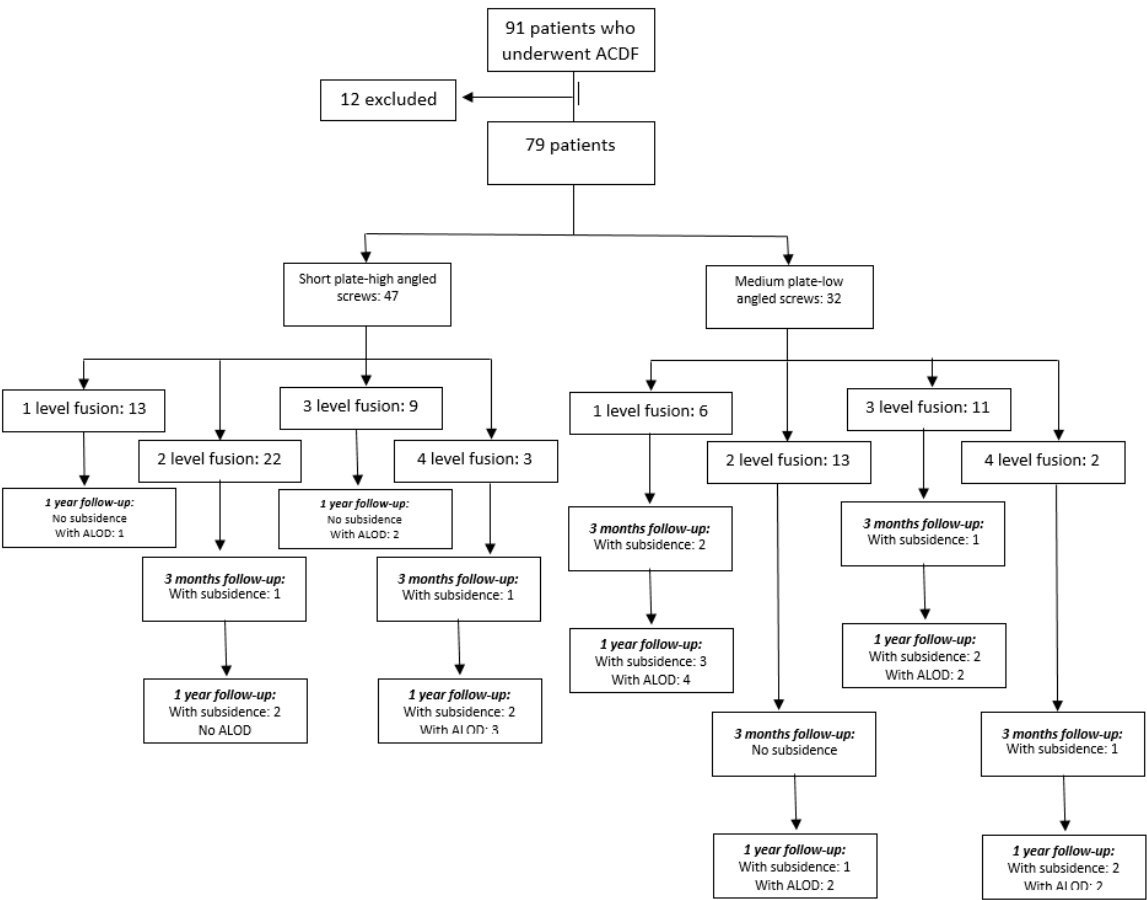
Figure 1. Flow diagram of methodology and results.